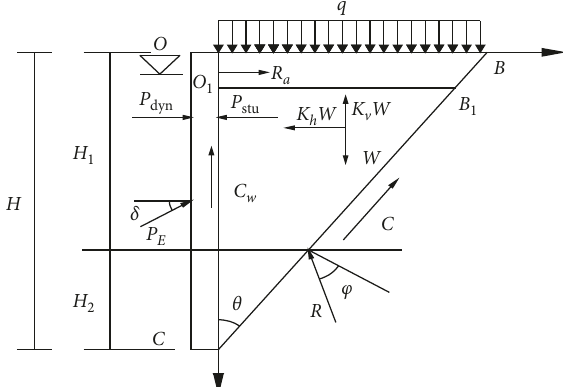
Figure 1: Diagram of the calculation